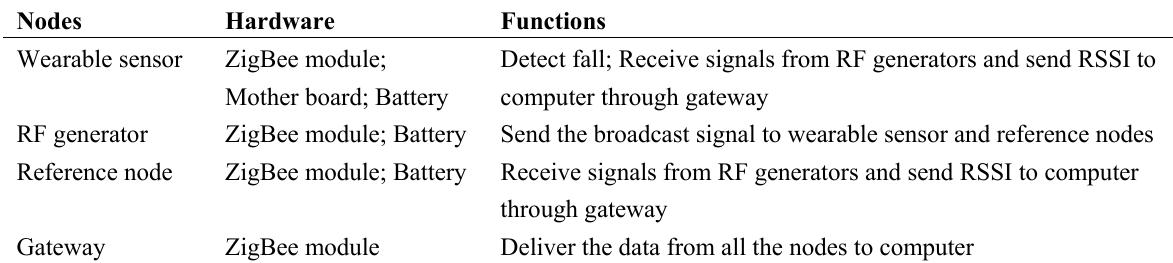
Table 1. The descriptions of nodes in the ZigBee-based location-aware fall detection system.